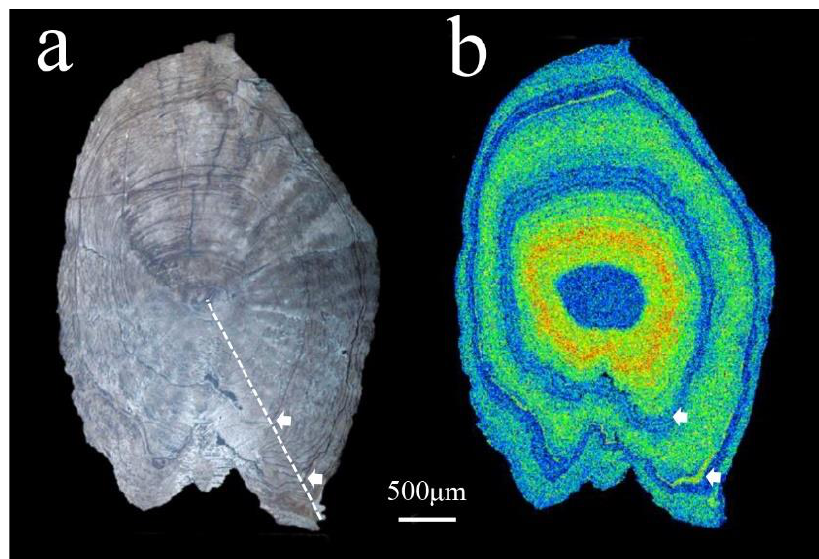
sea water (>7). The black arrows indicate the positions of the annuli.